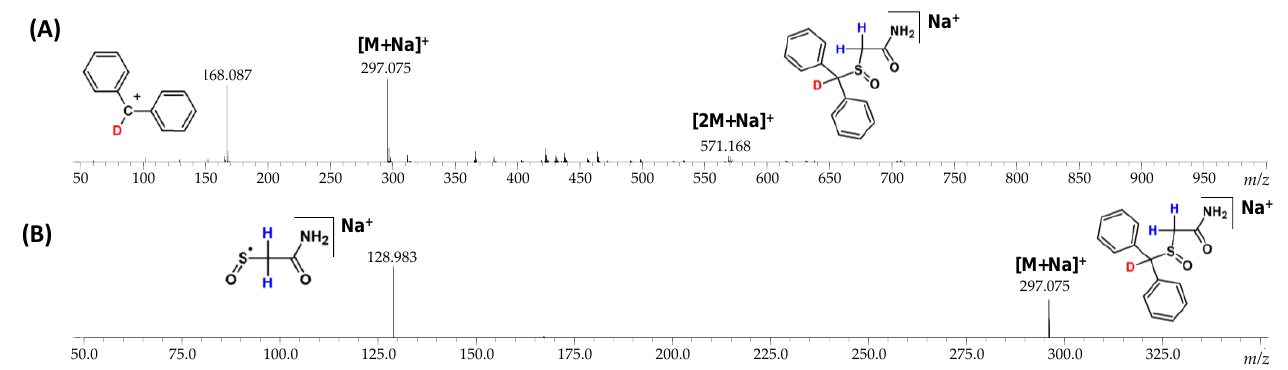
Figure 10. ( A ) ESI-MS and ( B ) MS/MS (parent ion 297.075 m/z , collision energy 30 eV) spectra of armodafinil-d 1 obtained after deuterium–hydrogen exchange.